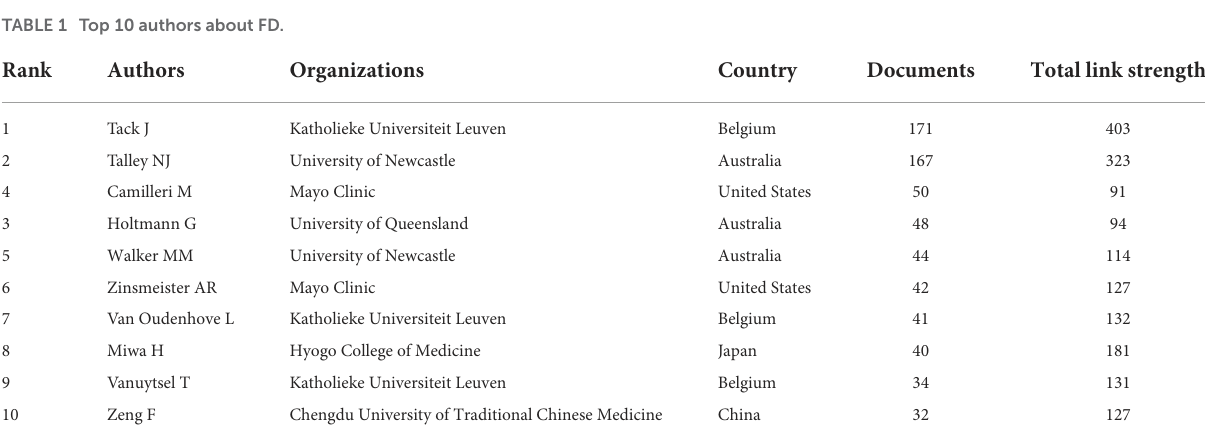
TABLE 1 Top 10 authors about